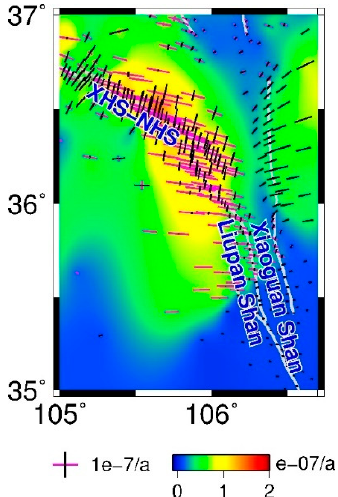
Figure 9 . The horizontal strain rate (the second invariant of the strain rate tensor) distribution for the Tibet – Ordos transition zone. The grey lines indicate the fault line (XHS-NHS: Xihua Shan-Nanhua Shan). The short black/pink lines are the principal compressive/tensile stress directions.